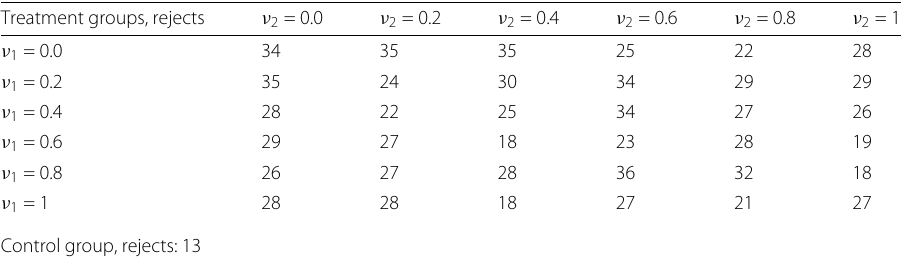
Table 5 Treatment groups: number of rejects (out of 100 runs) for goodness-of-fit tests of power-law models to in-degree distributions of interaction networks in online communities, with no onboarding (control group) and with onboarding Treatment groups, rejects ν 2 = 0.0 ν 2 = 0.2 ν 2 = 0.4 ν 2 = 0.6 ν 2 = 0.8 ν 2 = 1 ν 1 = 0.0 34 ν 1 = 0.2 35